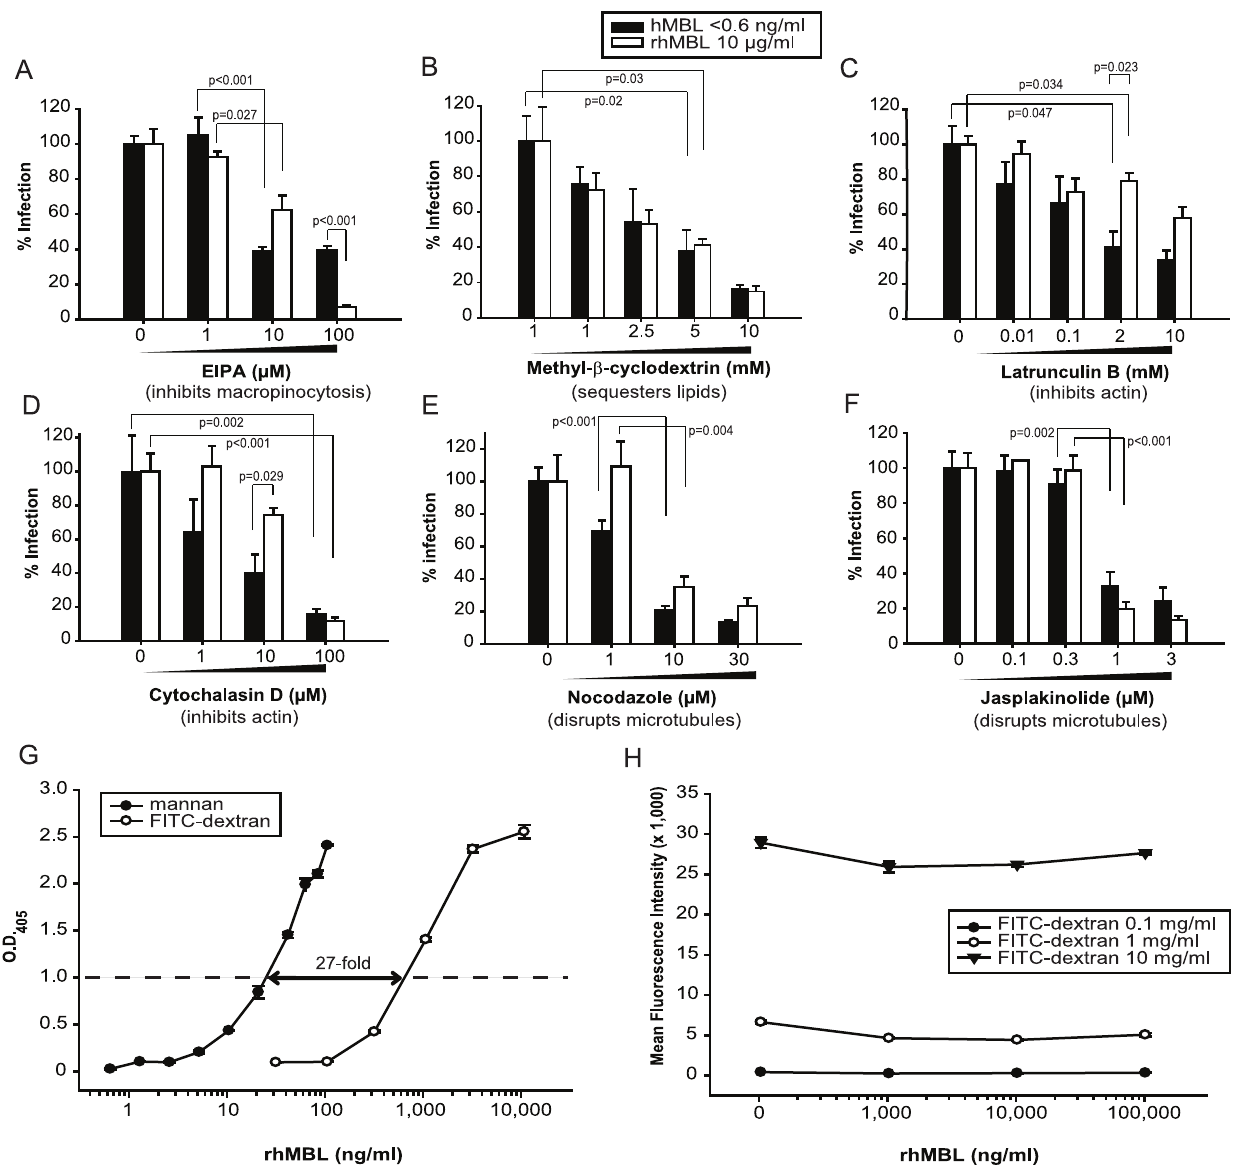
Figure 4. MBL mediates HIV-EBOV GP infection via the canonical macropinocytosis pathway for EBOV but with less dependence on actin. We preincubated HEK293F cells with (A) EIPA (5-( N -Ethyl- N -isopropyl)amiloride, a potent and specific inhibitor of Na + /H + exchanger activity), (B) methyl- b -cyclodextrin (extracts or sequesters cholesterol from the plasma membrane), (C) latrunculin B (blocks actin polymerization), (D) cytochalasin D (inhibits actin microfilament function), (E) nocodazole (disrupts microtubules), or (F) jasplakinolide (disrupts microtubules) in 5% MBL- deficient serum in the absence or presence of rhMBL at 37 u C for 1 hour. We then infected cells with HIV-EBOV-GP virion-like particles (1200 pg p24/ 100 m l). Percentages of infected cells are relative to DMSO controls. Luciferase values were adjusted for cell viability. Experiments were performed twice in quadruplicate. Significant differences are shown. (G) Absorbance values of an ELISA assay are shown indicating the difference in amount of rhMBL within the physiological range that binds to immobilized mannan or FITC-dextran (1 m g/100 m l). (H) We preincubated FITC-dextran with various concentrations of rhMBL at 37 u C for 30 minutes and then added the products to PMA-stimulated (10 ng/ml), IL-4-supplemented (100 ng/ml) THP-1 cells at 37 u C for 1 hour. We measured FITC-dextran uptake by flow cytometry and reported the results as mean fluorescence intensity (geometric mean fluorescence 6 percentage of cells). Experiments were performed twice in triplicate.